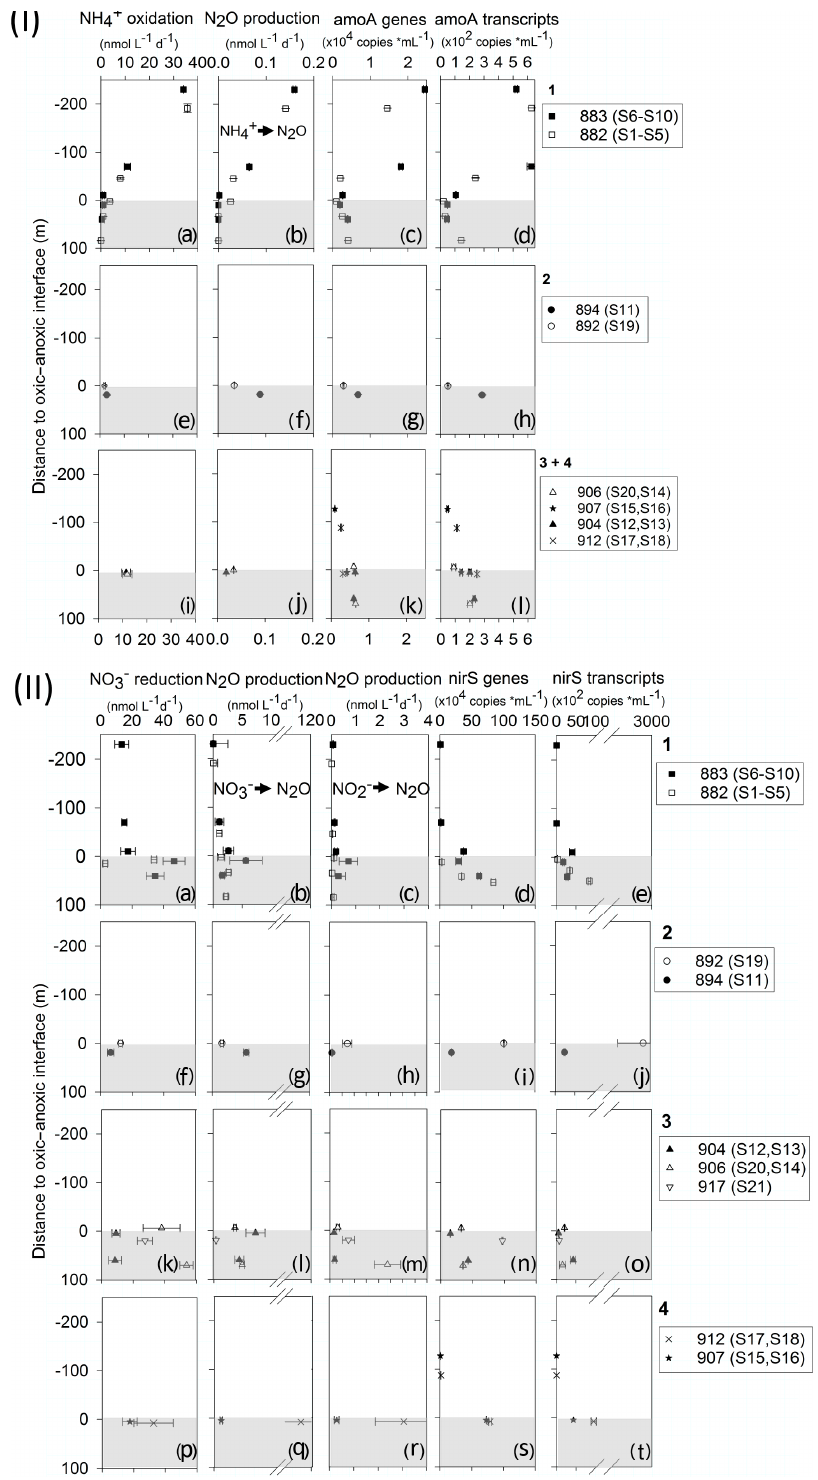
Figure 3. (I) Profiles of AO (a, e, i) , N 2 O production rates from NH + (b, f, j) , archaeal amoA gene (c, g, k) and transcript copy numbers per 4 (b, g, l, q) and NO − (c, h, m, r) , and nirS milliliter (d, h, l) . (II) Profiles of NO − reduction rates (a, f, k, p) , N 2 O production rates from NO − 3 3 2 gene (d, i, n, s) and transcript copy numbers per milliliter (e, j, m, t) . In (I) and (II) , the panel numbers 1–4 correspond to transect numbers. Negative values on the y axis represent shallower, oxic depths, and the positive values represent deeper, anoxic depth (0 = interface). Shaded area indicates the anoxic zone. Note the different scale for N 2 O production